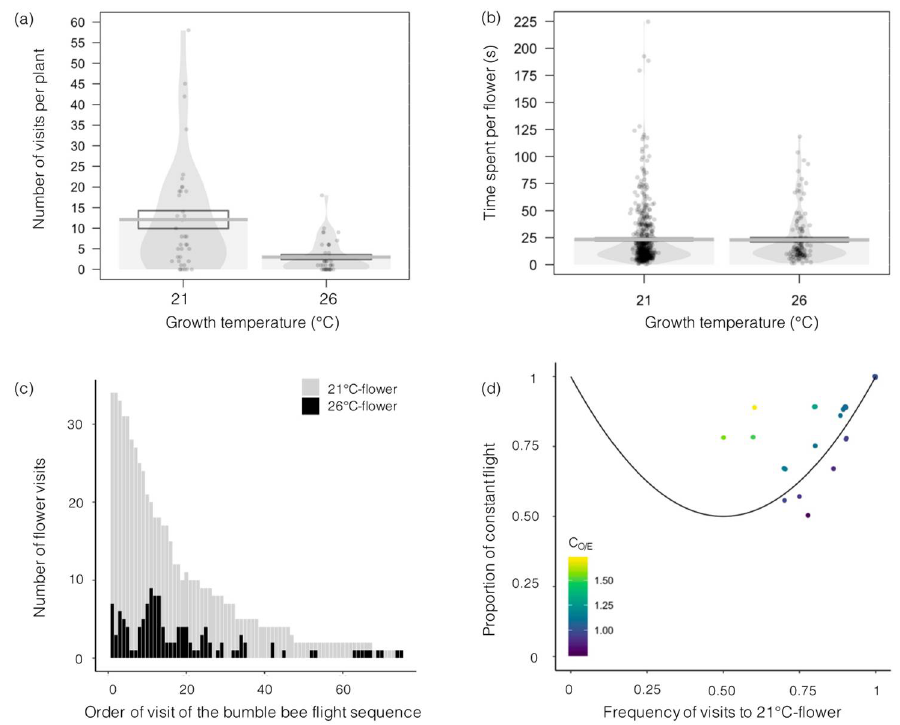
Figure 4. Effects of temperature on bumblebee visits to Borago officinalis flowers. ( a ) Number of flowers visited per plant (N = 60); ( b ) time spent per flower visit (N = 653); ( c ) number of flowers of plants grown at 21 °C or 26 °C that were visited according to the order of visit in each flight sequence (sum of all bumblebees flight sequences, N = 34 sequences); and ( d ) proportion of constant flights (from a flower from a plant grown at 21 °C (or 26 °C) to another flower from a plant grown at 21 °C (or 26 °C), divided by the total number of flights) in relation with the proportion of visits to flowers from plants grown at 21 °C. The C O/E coefficient equals 1 along the black line (a sequence above this line, with a C O/E larger than 1, will show more constancy than expected by chance). The choice to visit a flower was significantly predicted by flower height ( χ 2 =